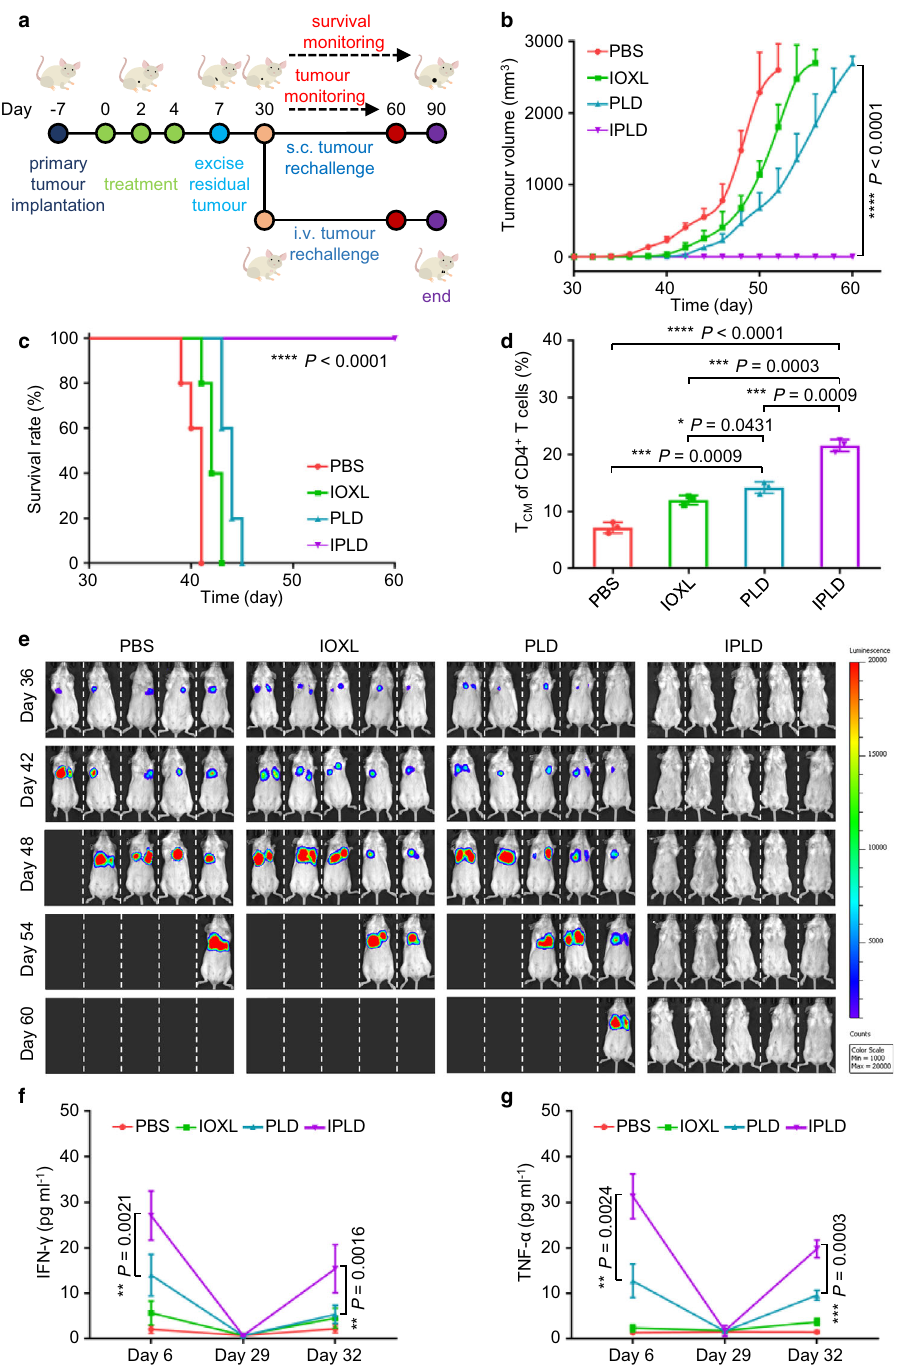
Fig. 7 IPLD treatment-induced long-term antitumour immunological memory tested by tumour rechallenging. a Experimental schedule: BALB/c mice with primary s.c. CT26 tumours of about 80 mm 3 were treated with the liposome formulas at 7.5 mg kg − 1 IOX1, 5 mg kg − 1 DOX every 2 days for three times; 3 days after the last treatment (Day 7), the tumours of the mice in the PBS, IOXL and PLD groups were surgically removed, and the wounds were sutured; the IPLD group needed no surgery as all the primary tumours disappeared after treatment. On Day 30, the mice in each treatment group were divided into two subgroups; one was s.c. inoculated with CT26 cells (5 × 10 5 ) and the other was i.v. injected with 5 × 10 5 Luci CT26 cells. b , c The tumour growth curves ( b ) and Kaplan – Meier analysis ( c ) of the mice bearing the rechallenged s.c. tumours; n = 5 mice. d Quantitative analysis of the central memory T cells (CD4 + CD44 + CD122 + ) in spleens of the mice on Day 11; n = 3 mice. e In vivo bioluminescence imaging the rechallenged lung tumours at different times; n = 5 mice. f , g The IFN- γ and TNF- α levels in the serum of mice in ( e ) on Day 6, 29, and 32; n = 3 mice. Data represent mean ± SD. Statistical signi fi cance was analyzed by two-tailed Student ’ s t test ( b , d , f , g ) or by the log-rank (Mantel – Cox) test ( c ). * P < 0.05, ** P < 0.01, *** P < 0.001, **** P < 0.0001. Source data are provided as a Source Data fi